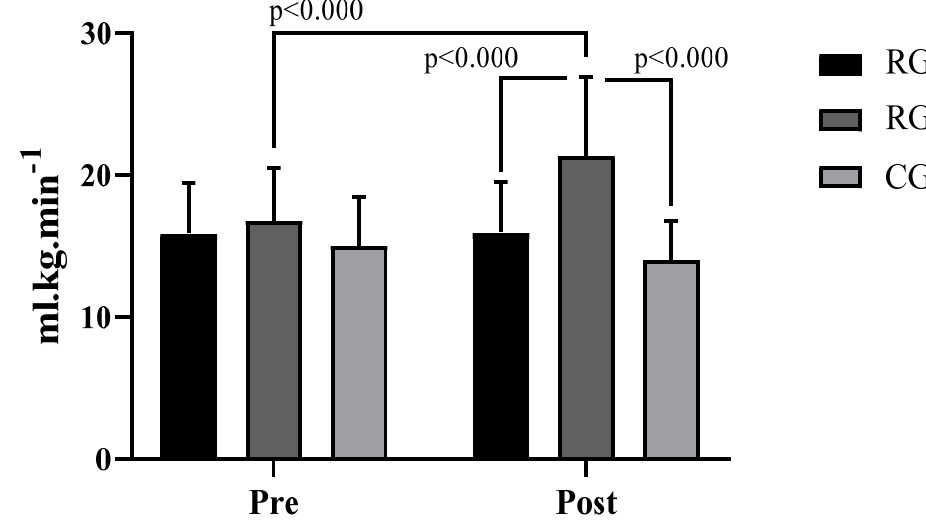
Figure 4. Relative VO 2max for the groups before and after the intervention.